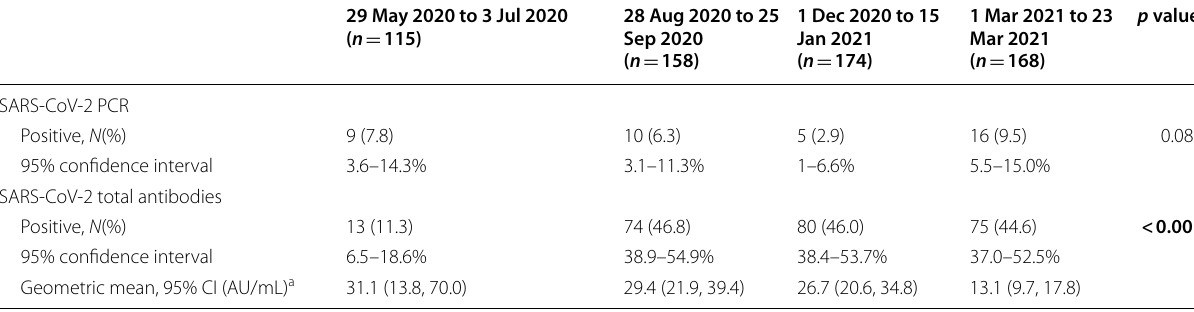
p value in bold indicates statistically significant outcome difference across four data collection periods a Geometric mean concentrations are calculated among participants who tested positive on SARS-CoV-2 total antibodies